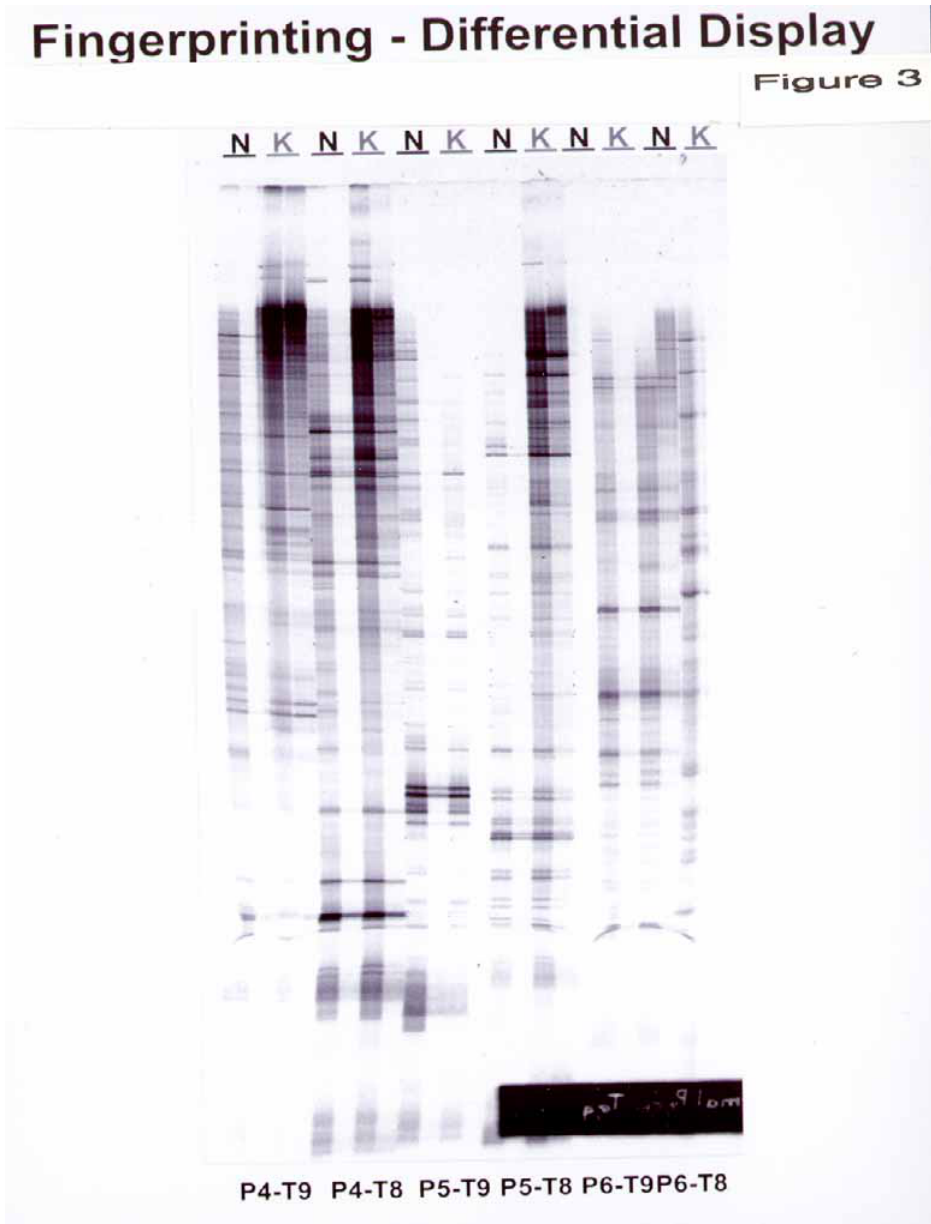
Figure 3. Differential display from normal versus keloid dermal fibroblasts using a Clontech's Delta  RNA Fingerprinting Kit. RNA was extracted as described in the Materials and Methods and reverse- transcribed with RTase. Polymerase chain reaction (PCR) of the resultant cDNA was performed with oligo(dT) PCR primers and arbitrary PCR primers listed in Table 1. The PCR products were analyzed on 6% DNA sequencing gel. Dots across the lanes indicate amplified mRNA present in the samples. The NDF and KDF samples were run as two lanes with one lane corresponding to the original mixture and the second lane corresponding to a dilute (1:100) sample